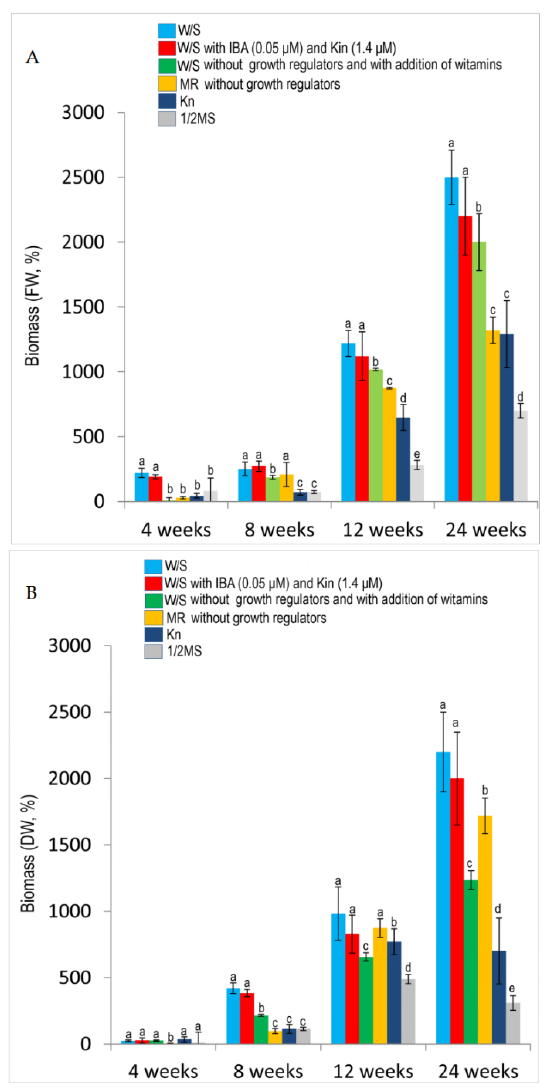
Figure 5. Effect of media and its composition on fresh (FW) ( A ) and dry (DW) ( B ) biomass increase in gametophytes culture. Data are expressed as mean ± SD of at least three independent experiments. Significantly different values are denoted by different lowercase letters ( p < 0.05). The statistical evaluation of the effect of media and its composition on biomass growth was evaluated in individual weeks (successively in weeks 4, 8, 12 and 24) but not between weeks.